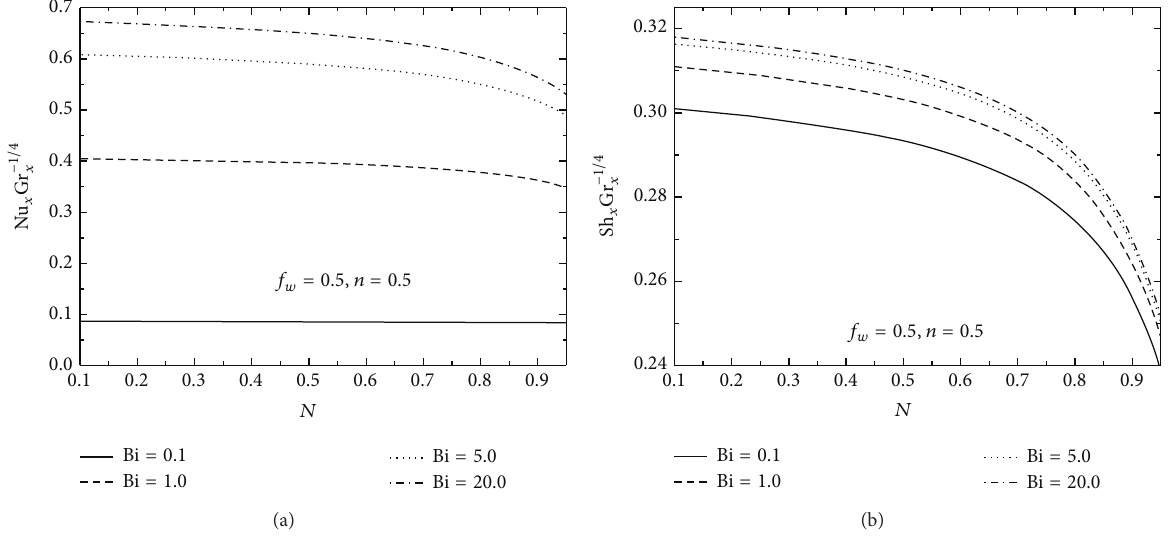
Figure 6: Effect of Bi on (a) heat transfer rate and (b) mass transfer rate.